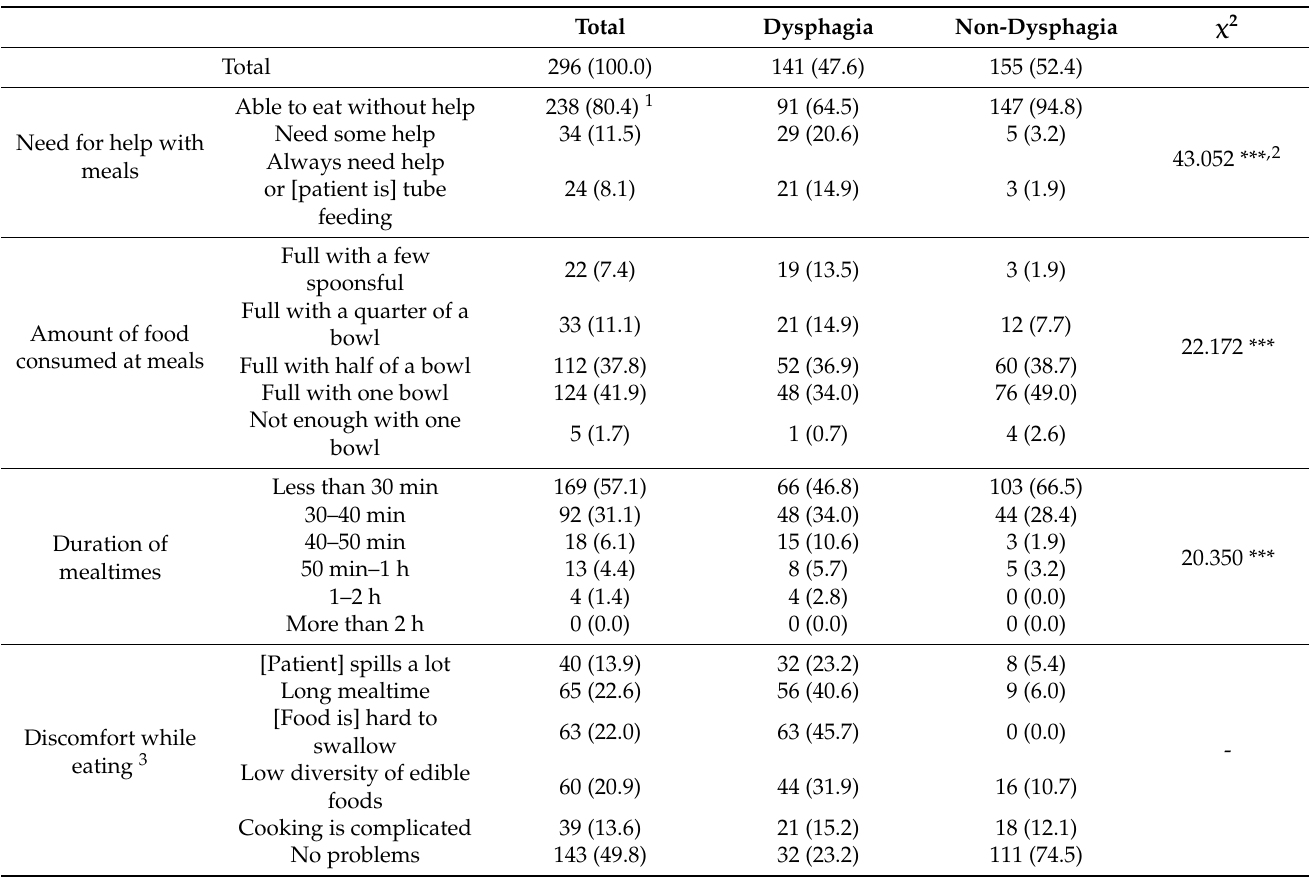
Table 2. Dietary Factors in the Dysphagia and Non-Dysphagia